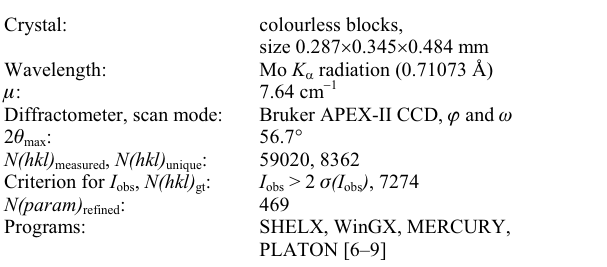
Table 1. Data collection and